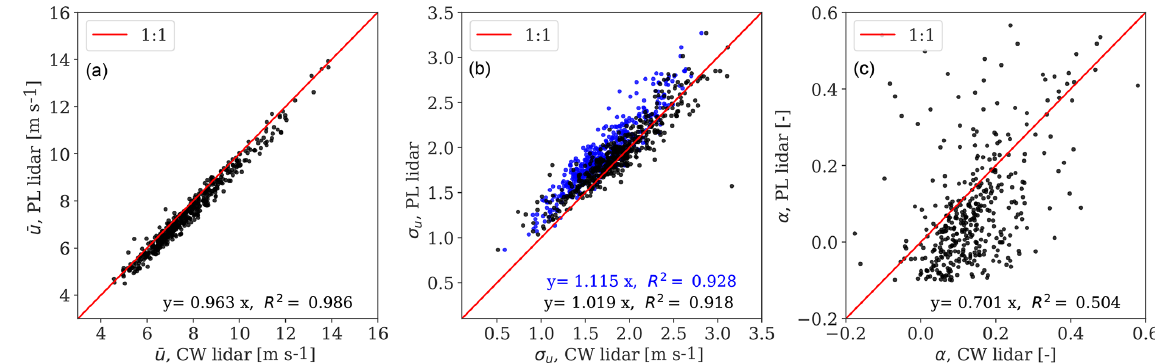
Figure 9. Same as Fig. 8 but for full-wake